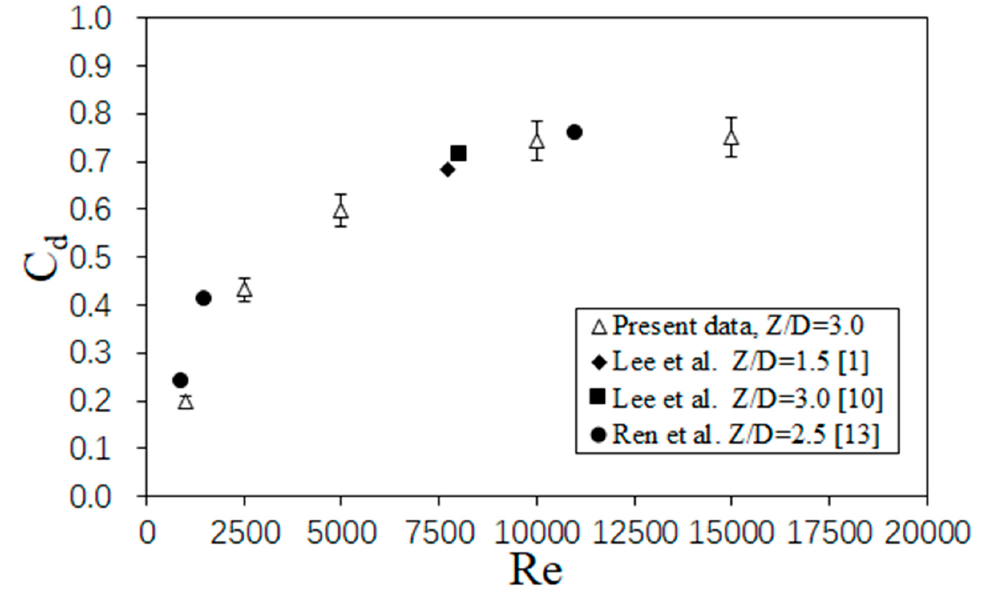
Figure 7. Discharge coefficient variation as dependent upon Re, including comparisons with Lee et al. [1,10] and Ren et al. [13].